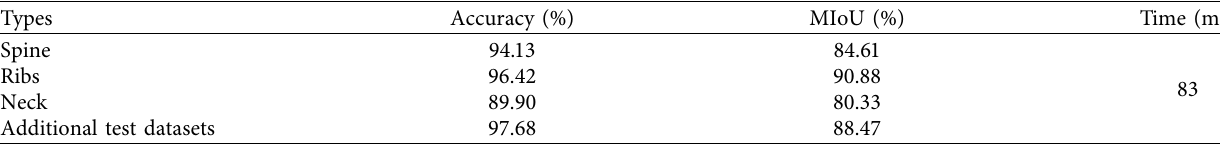
Figure 7: Loss value of nontransfer learning and transfer learning on the ICNet Table 3: Segmentation results of sheep carcass on the ICNet model.